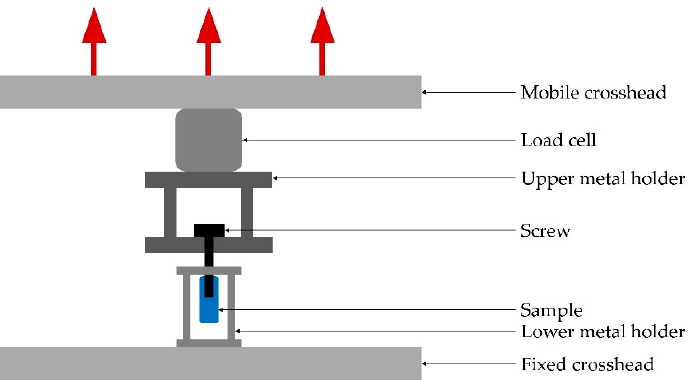
Figure 1. A cross-sectional illustration of the pull-out setup. The loading direction is indicated by red arrows.